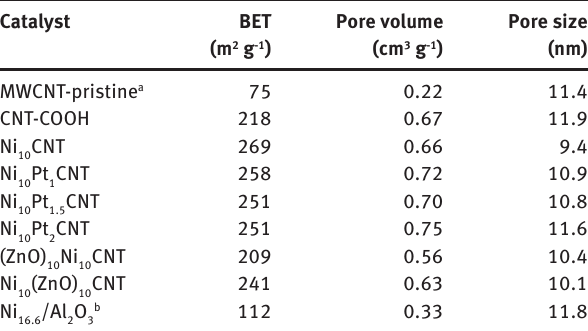
Table 1: Textural properties of fresh carbon nanotube (CNT)- supported catalysts results are adapted from [44], copyrights permission form University of